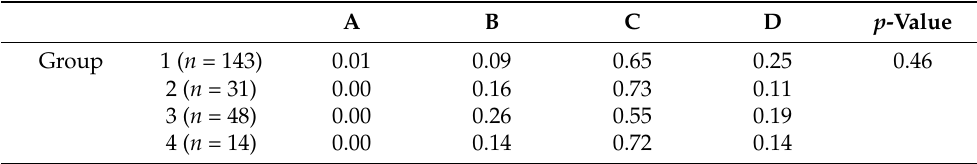
Table 3. Frequencies of CDH defect size (A–D) according to CDH study group consensus.